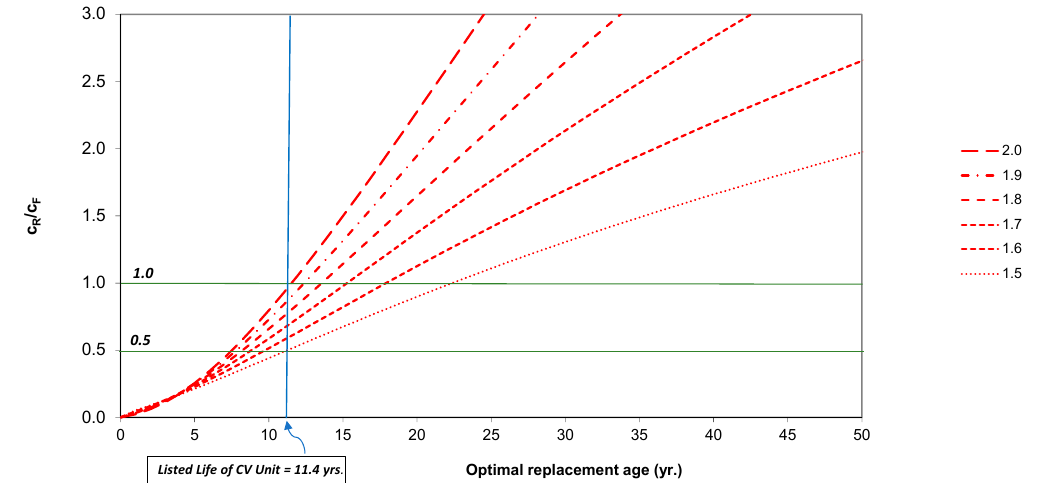
Figure 10. Sensitivity of replacement/failure cost ratio to Weibull shape factor.